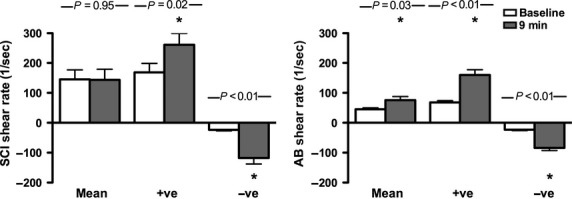
Shear rate responses to arm-crank exercise intervention. Mean, anterograde (+ve), and retrograde (−ve) shear rate patterns at baseline and at 9 min of arm-crank exercise for persons with spinal cord injury (SCI) and able-bodied controls (AB). Error bars represent standard deviation. *P-value < 0.05 baseline versus 9 min.